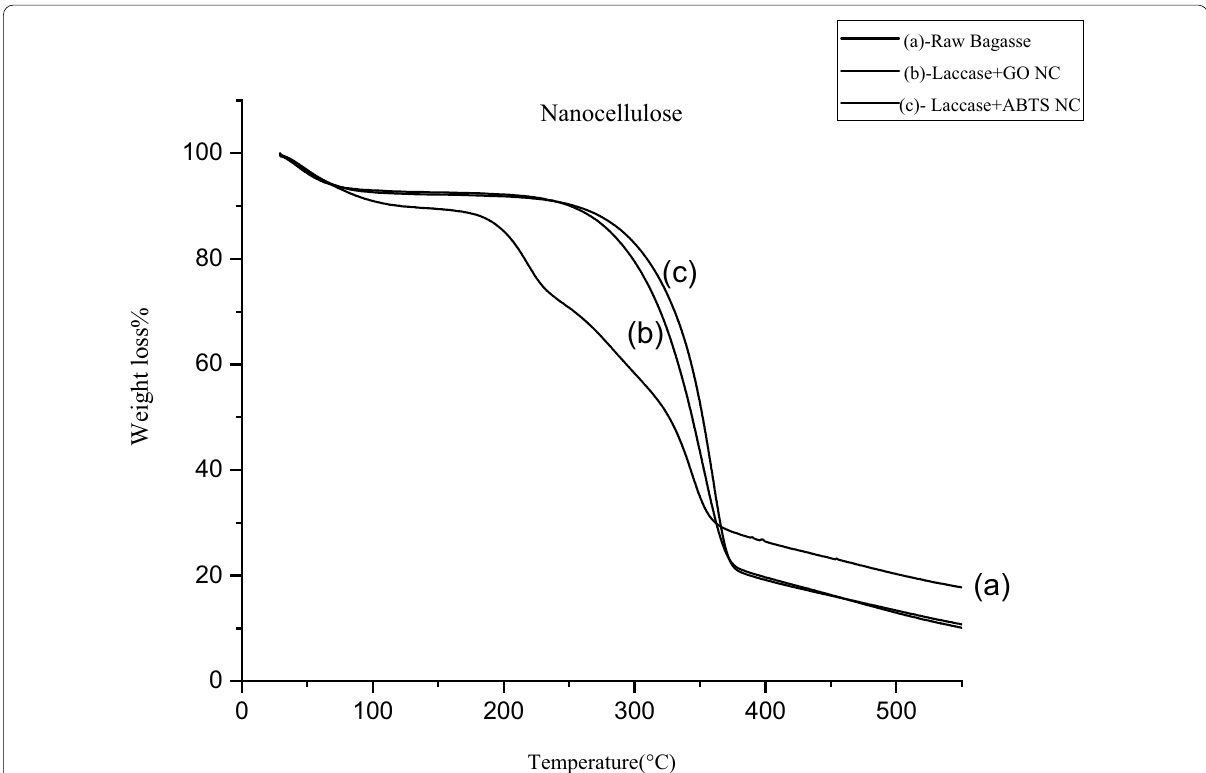
Fig. 11 TGA comparison between (a) raw bagasse and (b) laccase